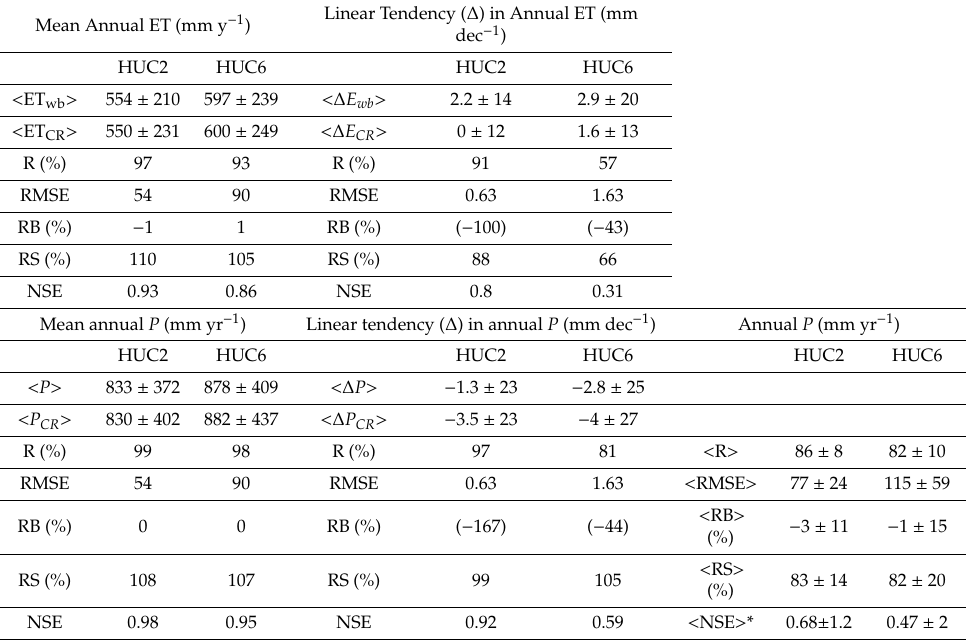
Figure 6. Regression plots of water-balance and GCR17-derived mean annual ET rates and least-squares fitted linear tendencies in their annual values (top panels); PRISM and water-balance-derived mean annualprecipitationratesandleast-squaresfittedlineartendenciesintheirannualvalues(bottompanels) for the HUC6 basins of the conterminous US. The sharp bracket denotes an arithmetic sample ( n = 327) mean. See the text for explanation of the statistical measures. Table 1. Statistical summary for the ET and precipitation (1979–2015)